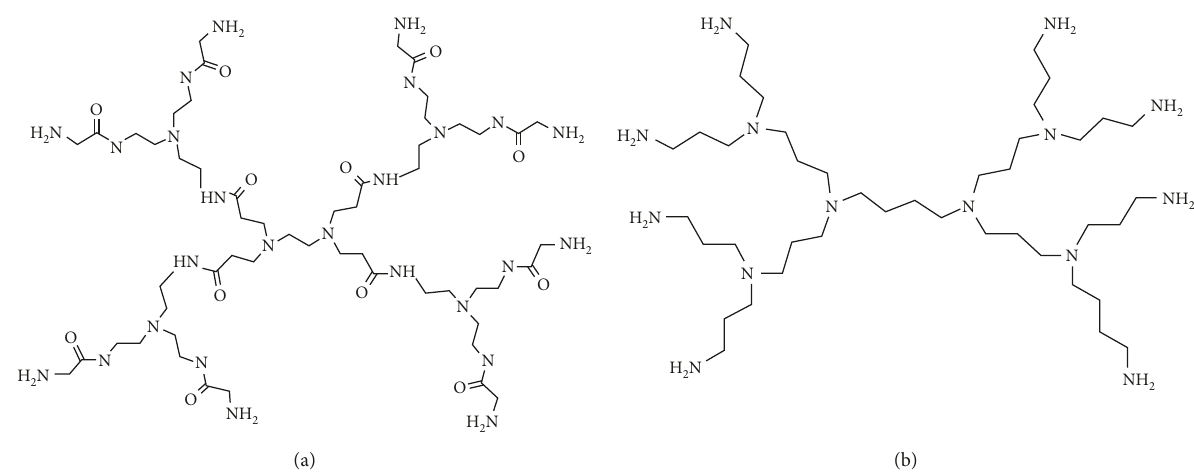
Figure 9: (a) A G1 PAMAM dendrimer and (b) G1 PPI dendrimer.